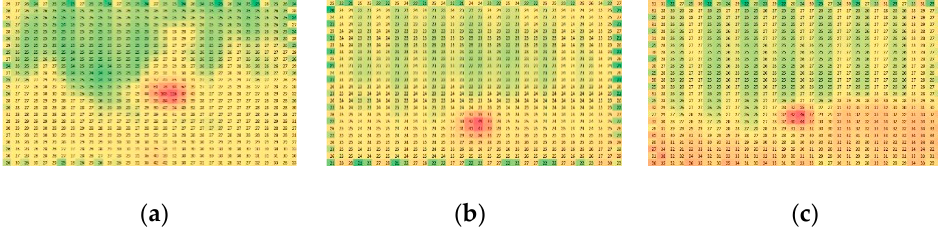
Figure 7. Experiment conducted at a distance of ( a ) 10 m; ( b ) 20 m; and ( c ) 30 m, respectively.